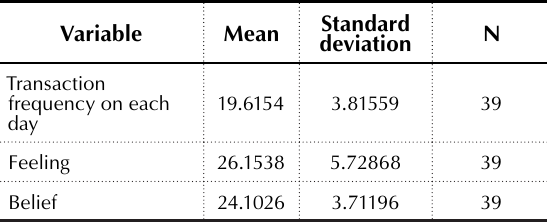
Table 3. Standard deviation for each LQ 45 stock